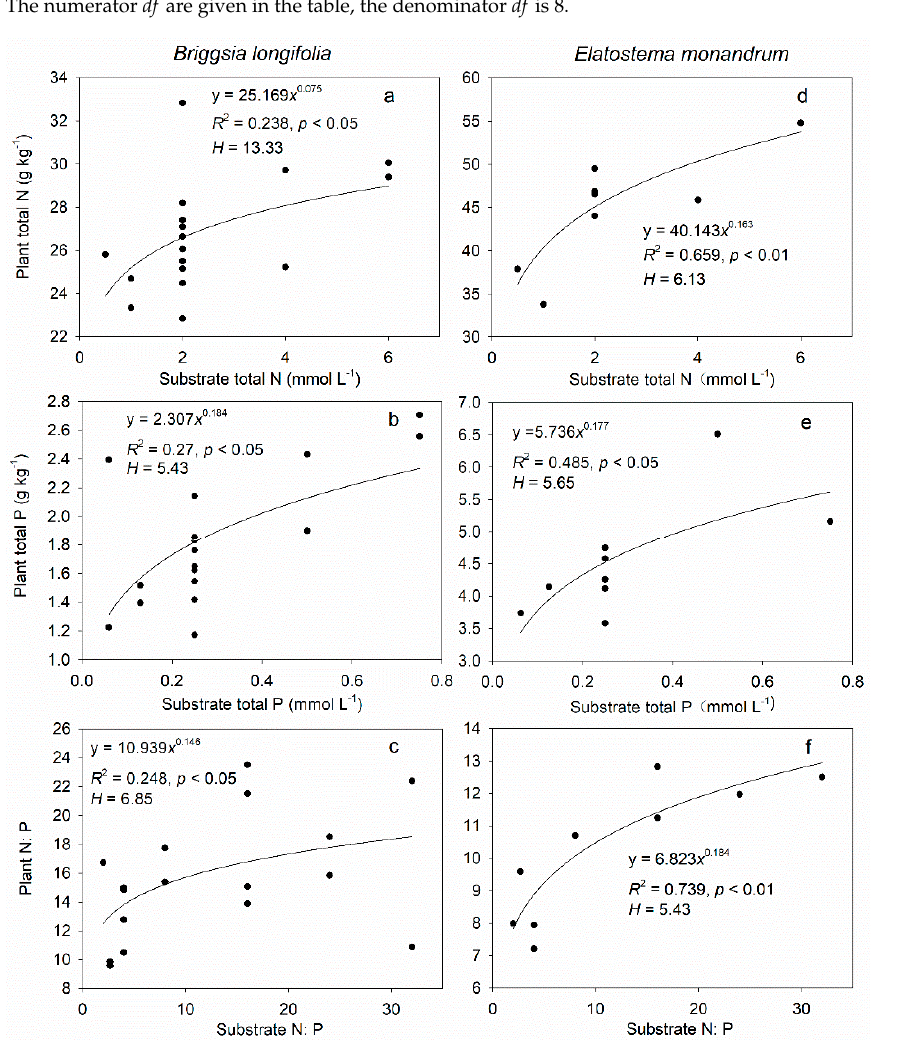
Figure 4. The statistics of homeostasis model and stoichiometric homeostasis ( H ) values for leaf N, P, and N:P in the greenhouse cultivation experiment. ( a , b , c ) H values for leaf N, P, and N: P of Briggsia longifolia , ( d , e , f ) H values for leaf N, P, and N: P of Elatostema monandrum , respectively.